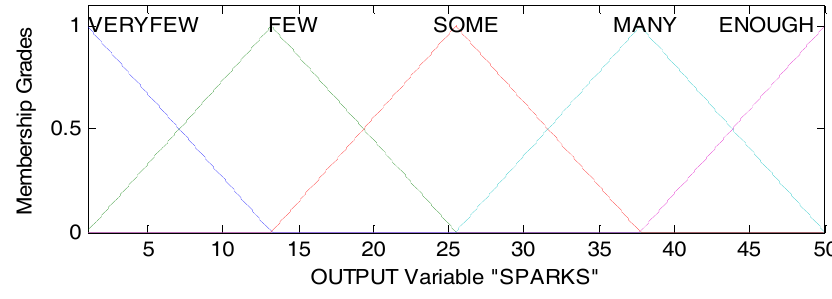
Figure 10. Output variable of DPFFWA-II (SPARKS).